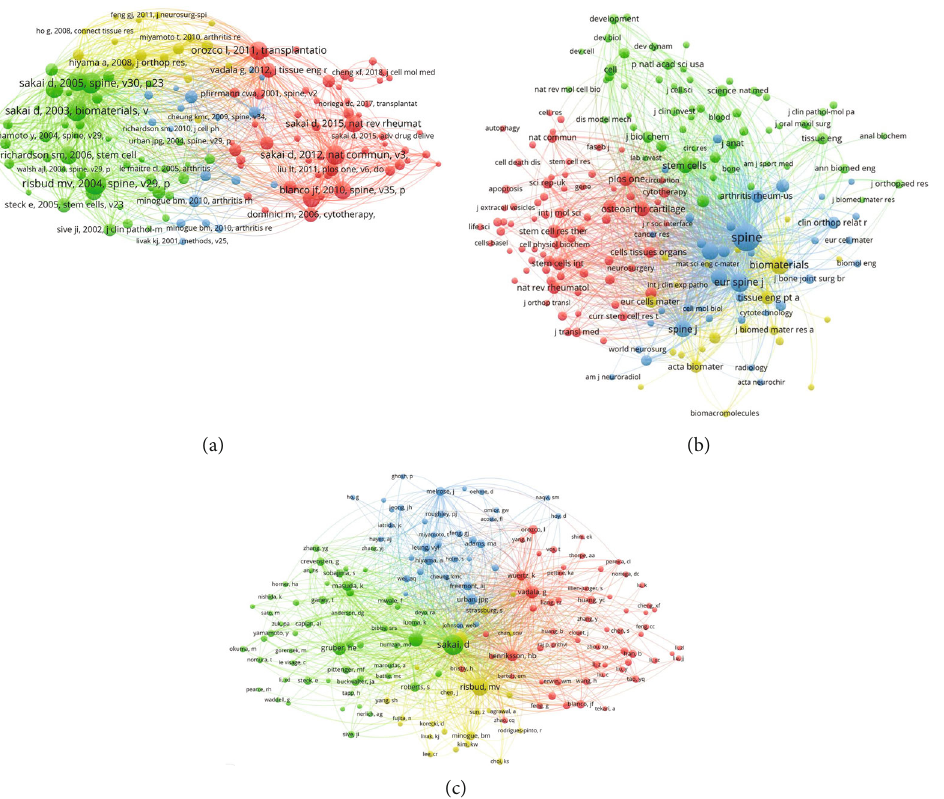
Figure 4: The co-citation analysis of (a) references, (b) journals, and (c) authors on stem and progenitor cells in intervertebral discs. (A point in the fi gure represents one reference, journal, and author, respectively. The color of the point represents di ff erent clusters; the size of the point represents the number of citations for each reference, journal, and author, respectively. The more the number, the larger the point. The connection between the two points represents two papers are jointly cited by another paper, and the length of the connection between the two points represents the correlation between two articles; the shorter the line, the stronger the correlation).